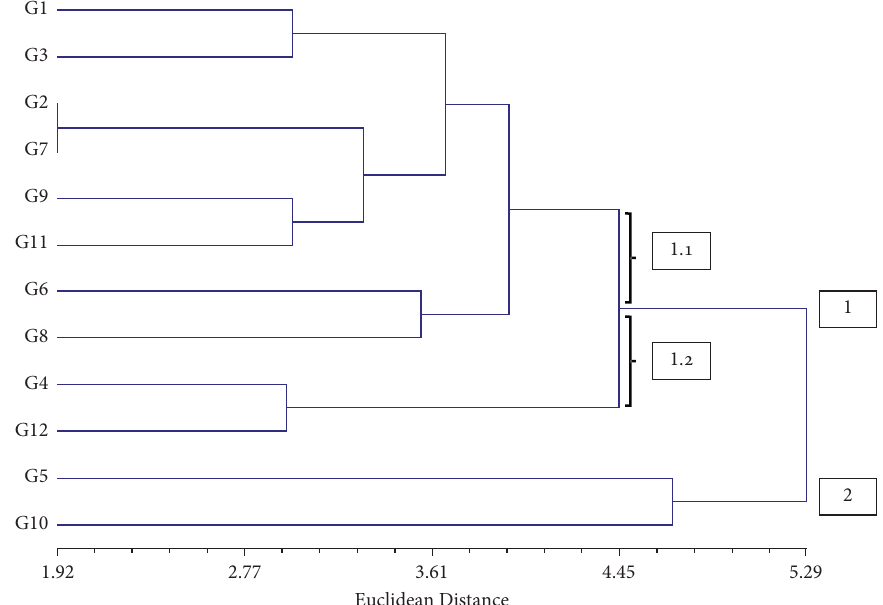
Figure 5: Dendrogram for nine genotypes of PFSP and three commercial varieties as checks based on agronomic traits in Cilembu